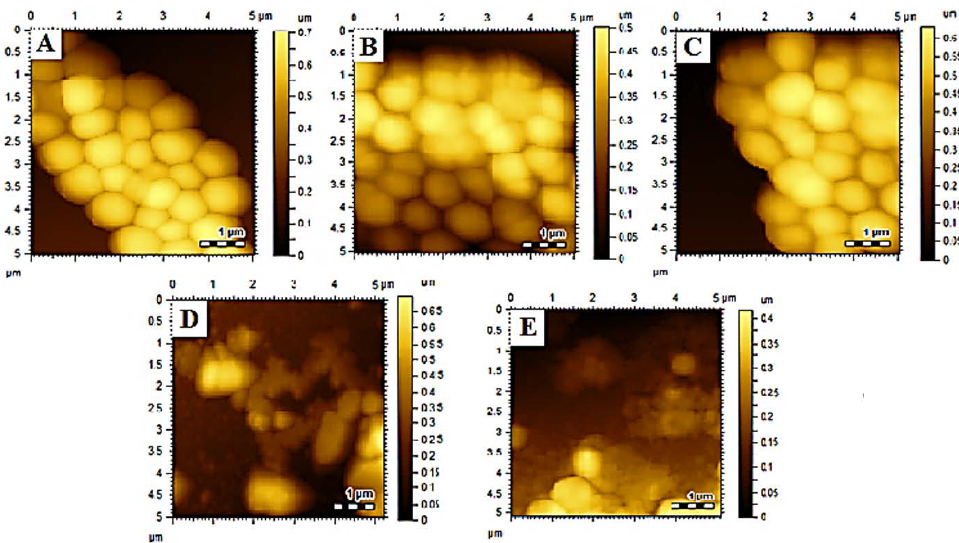
Figure 7. A surface morphological analysis of Staphylococcus aureus (clinical isolate) control after incubation ( A ), VCM treated ( B ), Fe − MIL − 88NH 2 treated and ( C ), VCM − Fe − MIL − 88NH 2 treated ( D ), and MNS-VCM − Fe − MIL − 88NH 2 treated ( E